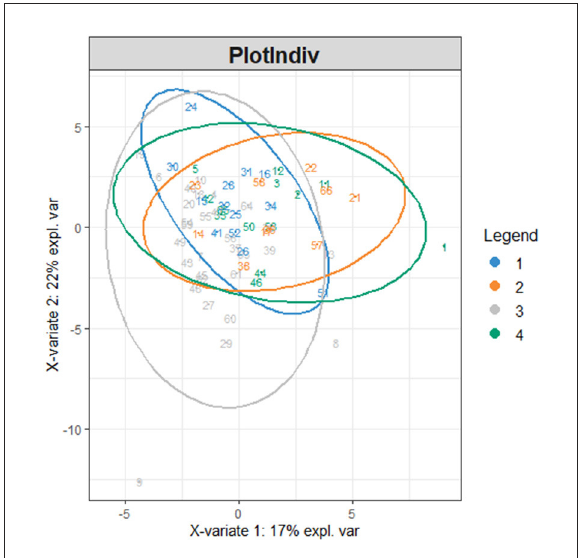
FIGURE4 PlotIndiv. The four groups: group 1 = normal rotator cuff with normal clinical routine serum lipid test results; group 2 = normal rotator cuff with abnormal clinical routine serum lipid test results; group 3 = rotator cuff tear with normal routine serum lipid test results; group 4 = rotator cuff tear with abnormal routine serum lipid test results. Traditional abnormal clinical plasma lipid levels were defined as abnormal levels for at least two of four lipids (TG ≥ 1.70 mmol/L; TC ≥ 5.18 mmol/L; L-DLC ≥ 3.64 mmol/L; HDL-C ≤ 1.04 mmol/L). X-variate 1 and X-variate 2 represent the measured rate of the built model for X and Y matrices,